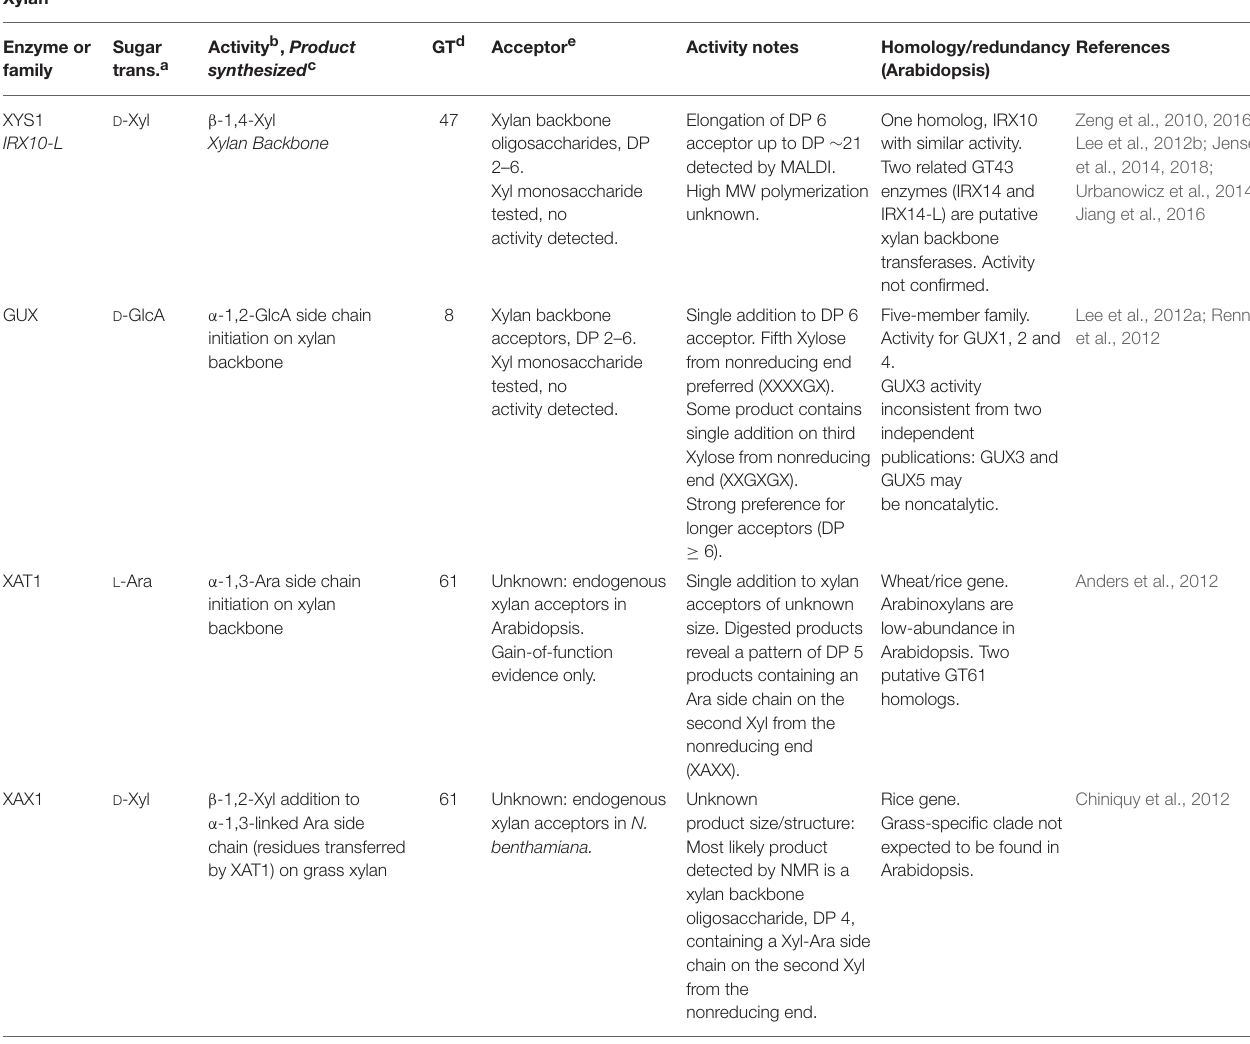
TABLE 2 | Xylan biosynthetic GTs of known function determined by heterologous